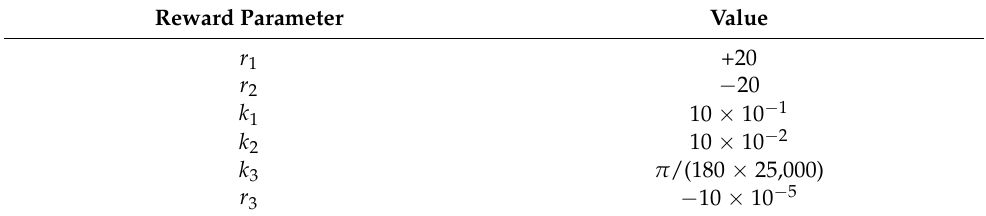
Table 6. Parameters of the reward